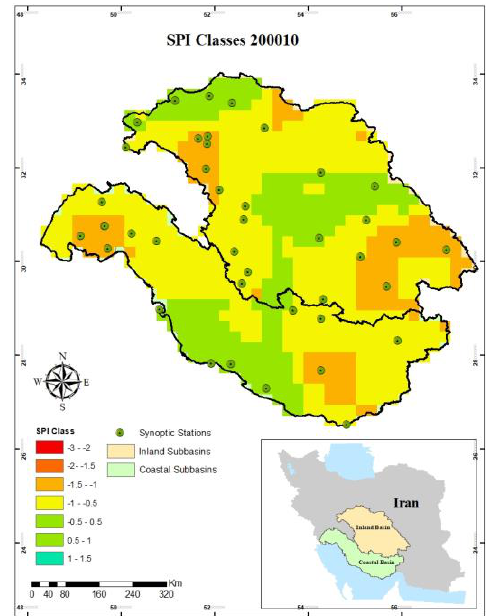
Figure6. SPI Value calculated from TRMM3B43